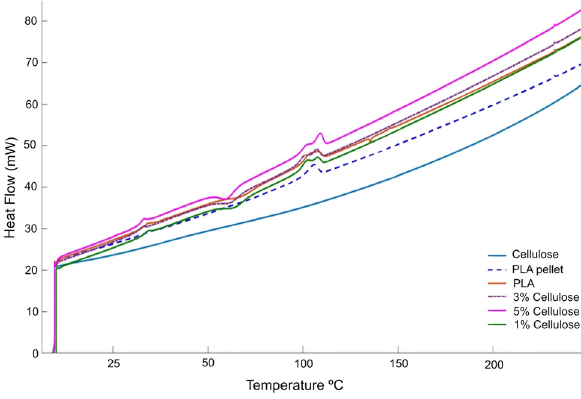
Figure 3: Comparative thermal analysis of di ff erential scanning calorimetry ( DSC ) .